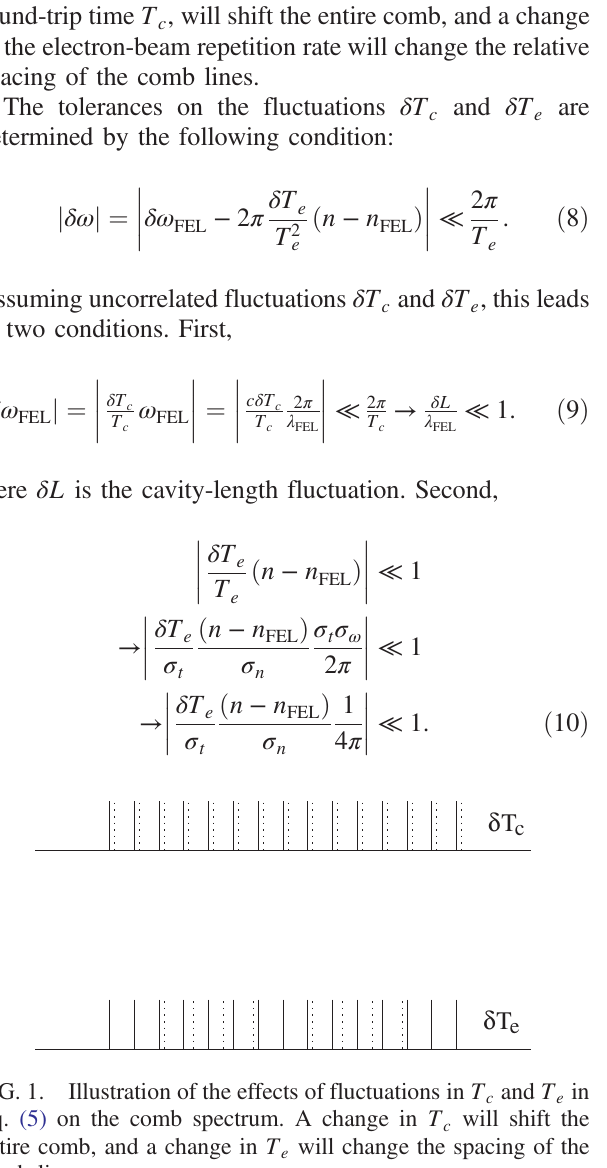
FIG. 1. Illustration of the effects of fluctuations in T Eq. (5) on the comb spectrum. A change in T entire comb, and a change in T comb